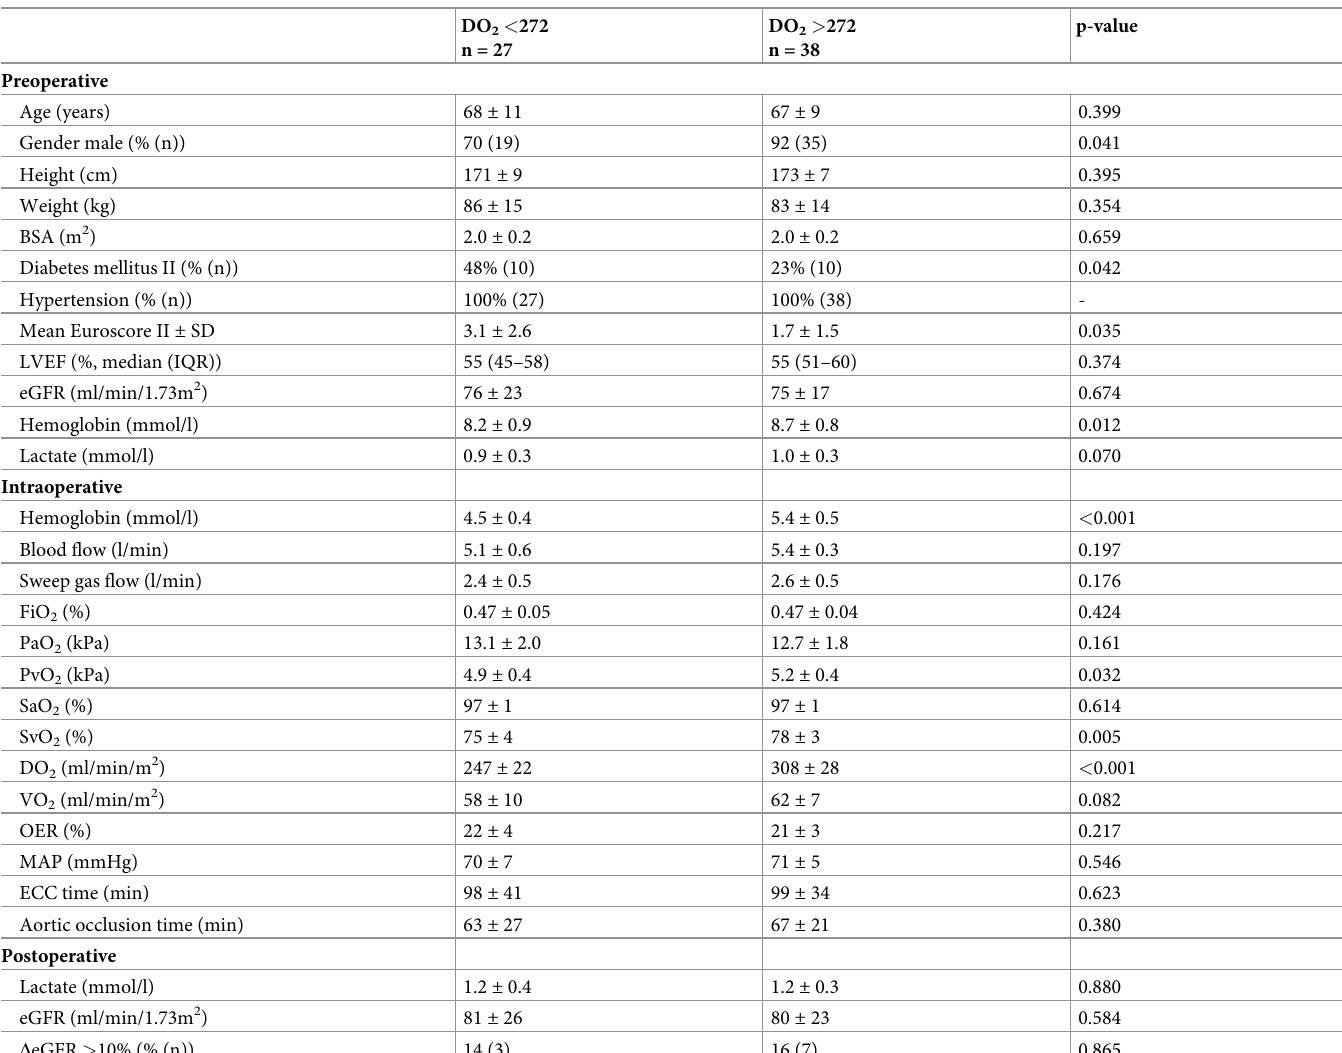
Table 1. Pre-, intra- and postoperative characteristics split on average DO 2